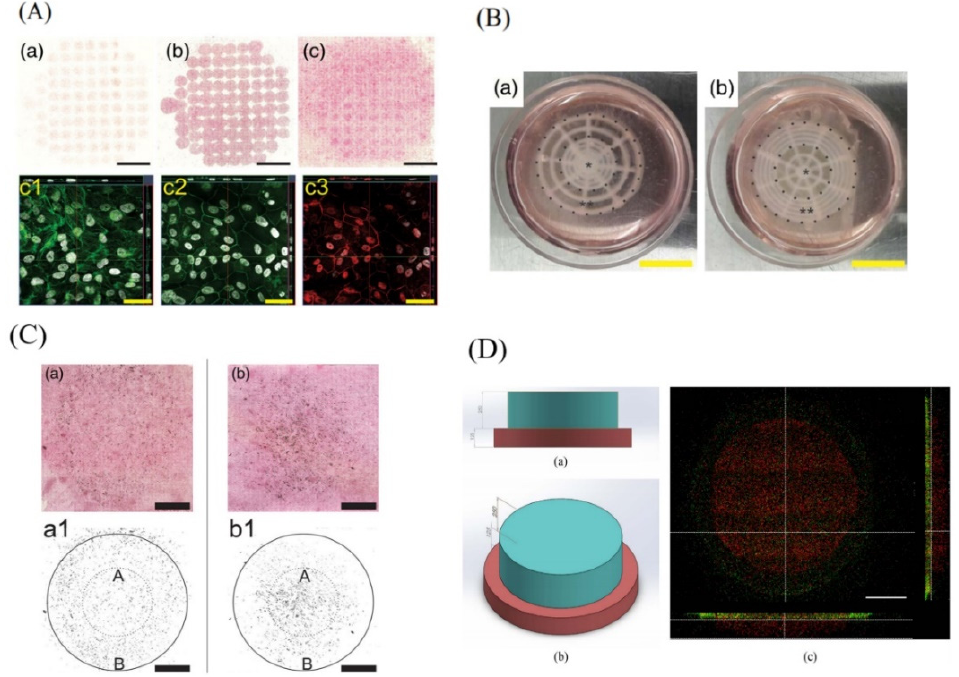
Figure 8. ( A ) Bio-printed ARPE-19 cells ( a – c ): hematoxylin and eosin staining at days 1, 7, and 14, respectively, scale bar: 5 mm. Confocal images of ARPE-19 cell layers at Day 14: F-actin cytoskeleton immunofluorescence staining ( c1 ), Zonula occludens-1 ( c2 ) in green, Claudin-1 ( c3 ) in red, and nuclei in grey, scale bar: 50 µ m. Reproduced with permission form [75], Wiley, 2018. ( B ) The bio-printed retinal equivalents with two distinctive Y79 cell-seeding density: high average cell density at the center ( a ) and high average cell density at the periphery ( b ); *: central area, **: periphery; scale bar: 10 mm. Reproduced with permission from [24], Whioce Publishing Pte. Ltd., 2017. ( C ) Hematoxylin and eosin staining of the bio-printed Y79 cells with two distinctive patterns on ARPE-19 cell monolayer at Day 14: high density at periphery ( a ) and high density at the central area ( b ). Data analysis (integrated intensity) of bio-printed Y79 proliferation after 14 days, high density at periphery ( a1 ), and high density at the central area ( b1 ); A = area of the inner circle; B = area of the annulus; diameters: small circle (10 mm) and large circle (20 mm); scale bar: 5 mm. Reproduced with permission from [75], Wiley, 2018. ( D ) Bilayer printing of fluorescent labelled hydrogels: ( a ) Top view and ( b ) side view of structural design from SolidWorks ® ( c ) Confocal fluorescent images showing bilayer construct. The printed structure recapitulated the structural design, indicating ability to construct multi-layered structure. Scale bar = 500 µ m. Reproduced with permission from [76], Elsevier,